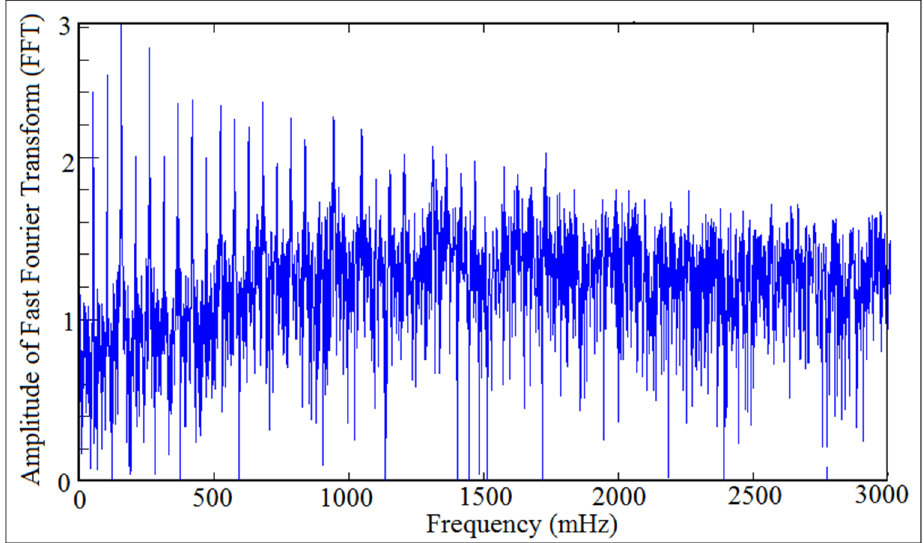
Figure 25. Power density function of the numerical simulation.